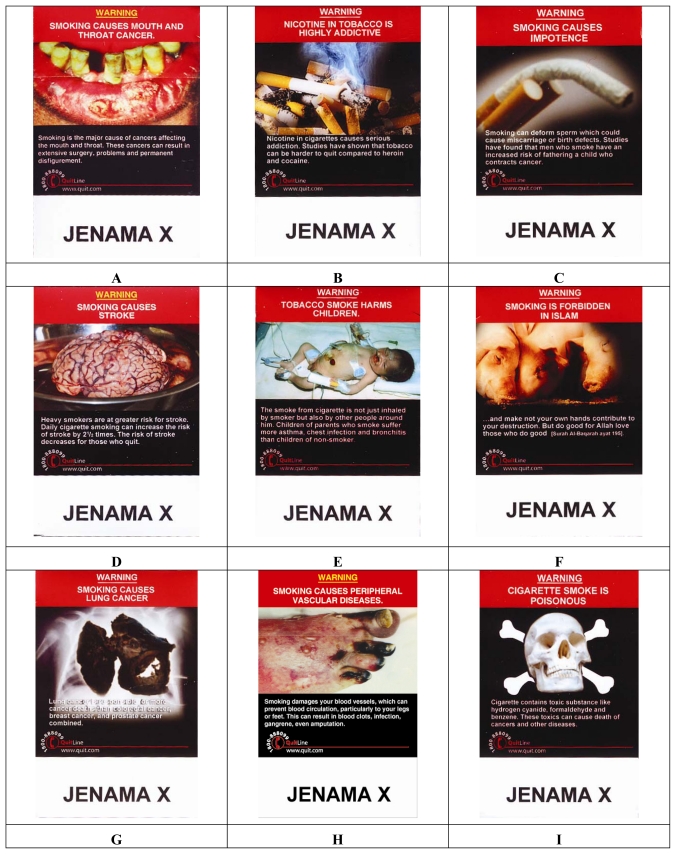
The nine designs used as mock-ups in the study.